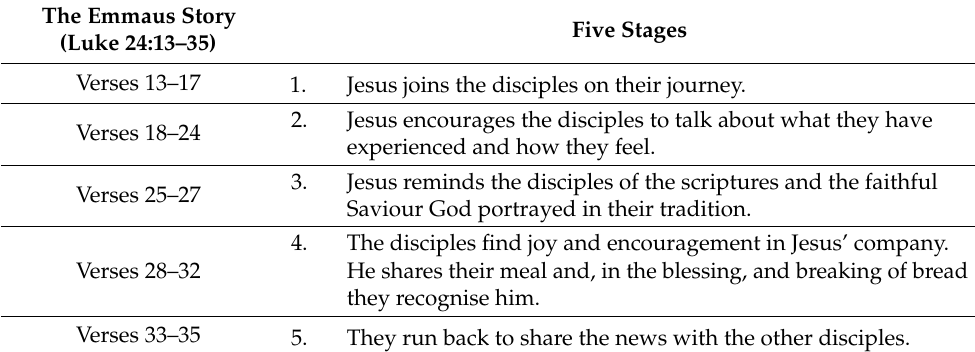
Table 1. Table 1. The Emmaus